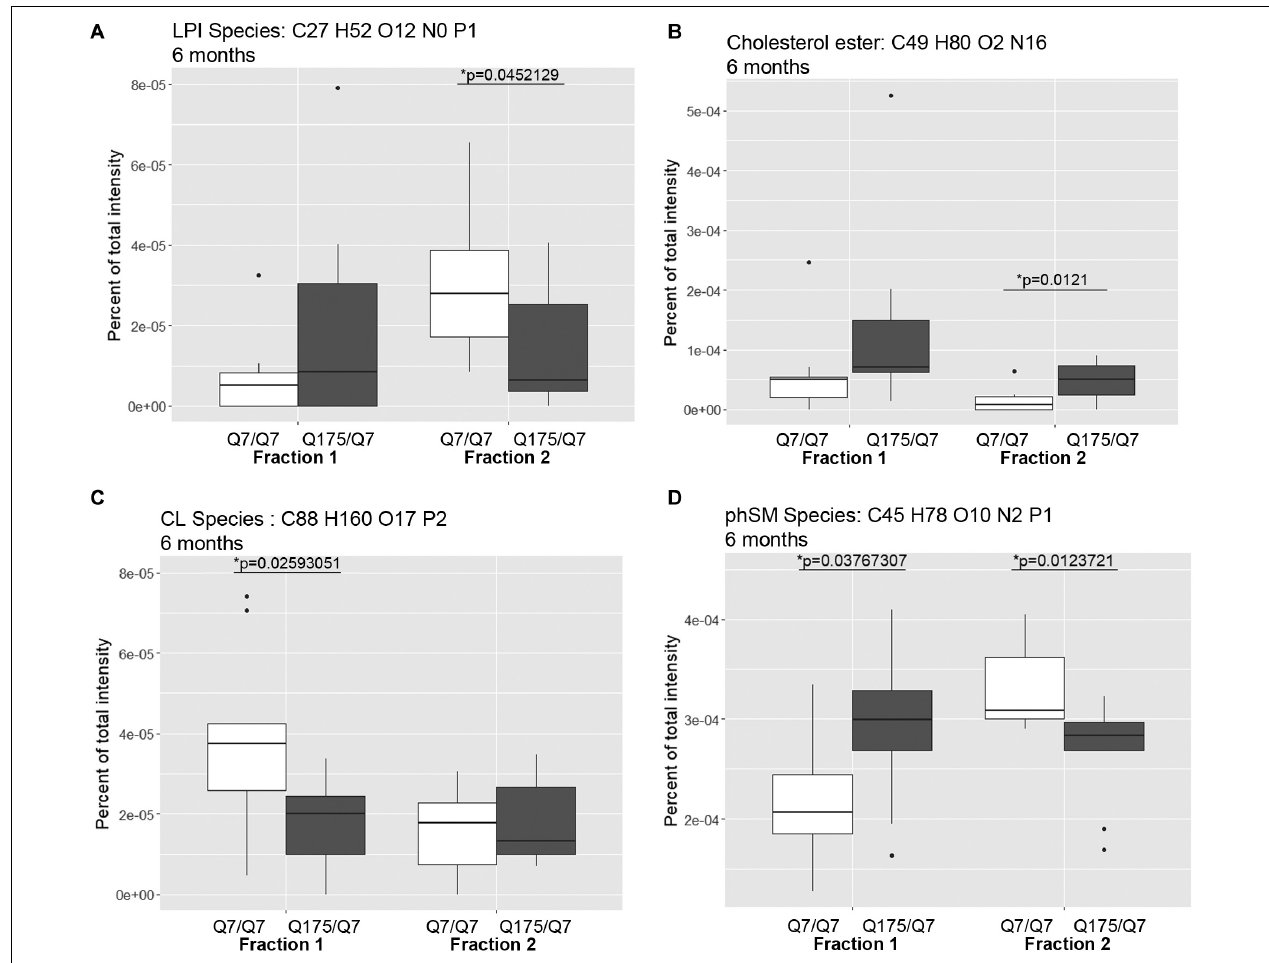
FIGURE 3 | Levels of selected individual species of lipids detected by LC-MS/MS in fractions 1 and 2 of continuous density gradients of fractionated 6 months old Q175/Q7 and Q7/Q7 striata. Graphs show Tukey-style box plots where the lower and upper hinges correspond to the first and third quartiles (the 25th and 75th percentiles) as described in section “Materials and Methods.” Data beyond the end of the whiskers are called “outlying” points and are plotted individually. Outliers were not removed from statistical analysis. NOT DETECTED indicates species was not detected using the modified 80% rule (Yang et al., 2015). Changes at 6 months are shown for specific species of (A) lyso-phosphoinositol (LPI), (B) Cholesterol ester, (C) Cardiolipin (CL), and (D) Sphingomyelin, phytosphingosine (phSM). All significant changes are shown in Supplementary Tables 1–8 . Comparisons were made between genotype for each fraction ( ∗ p < 0.05, unpaired t -test, N = 9 per group).